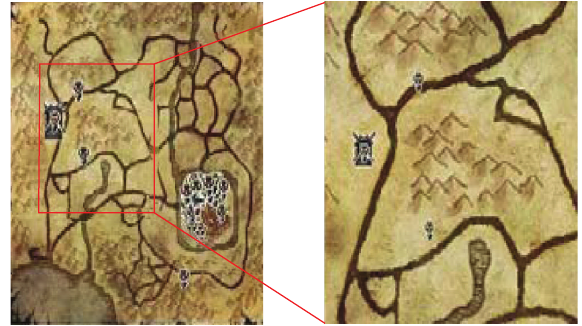
Figure 3: Normal map versus zoom-in